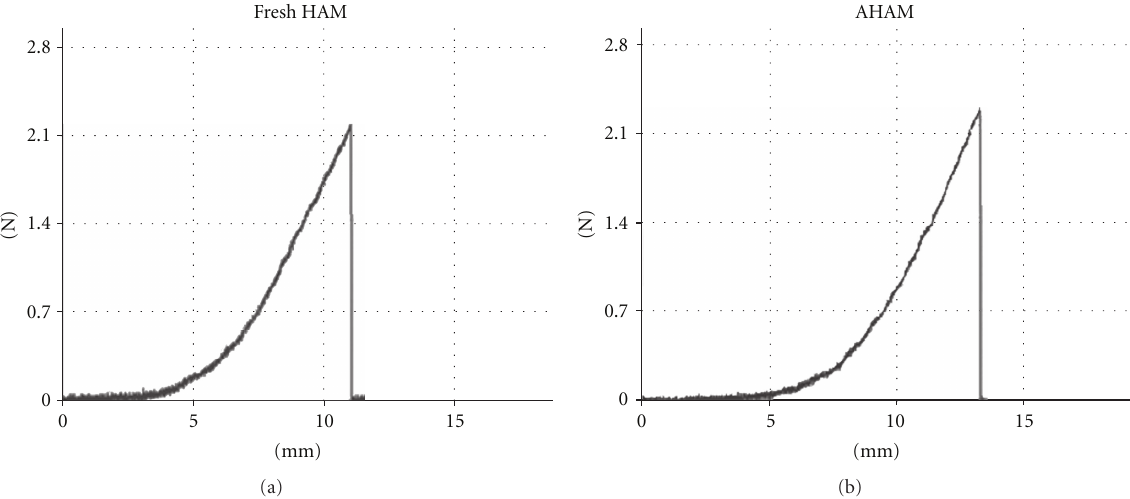
Figure 2: Biomechanics of the AHAM. (a) Fresh HAM and (b) AHAM samples were tested under a uniaxial tensile low strain and loading to failure using an electronic universal testing machine. No di ff erences between fresh HAM and AHAM were observed in the stress-strain